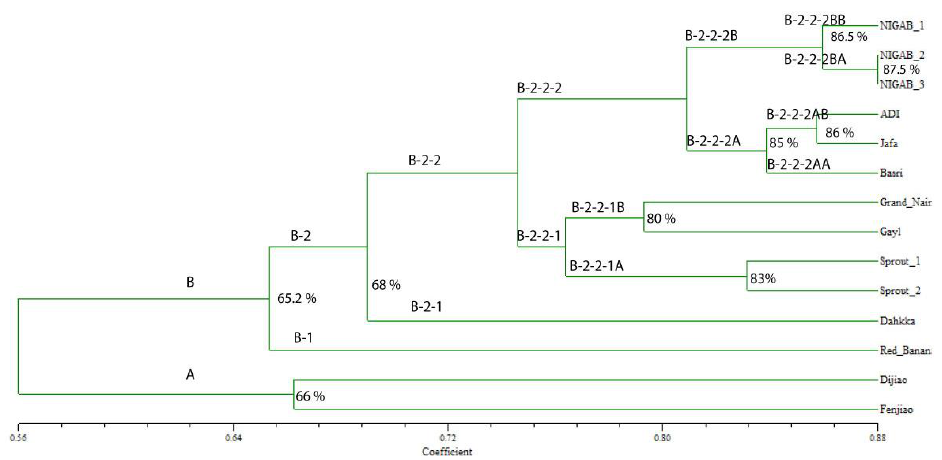
Figure 1. Dendrogram showing the relationships among 14 banana varieties from Pakistan. The similarity coefficient ranged from 0.56–0.88. Multivariate analysis divided 14 banana varieties into two distinct groups, A and B, indicating the varieties in group A were 66% and group B 88% similar to the rest of the population at the molecular level. The result of this analysis showed that the maximum genetic distance was 34% in group A (Dajiao and Fenjiao). A minimum genetic distance of 12% was observed in group B between two local varieties NIGAB-2 and NIGAB-3 .